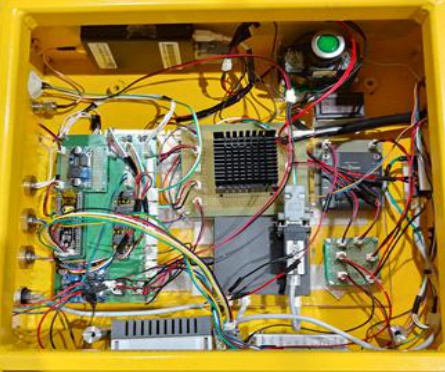
Figure 2. The control box of the USV system.